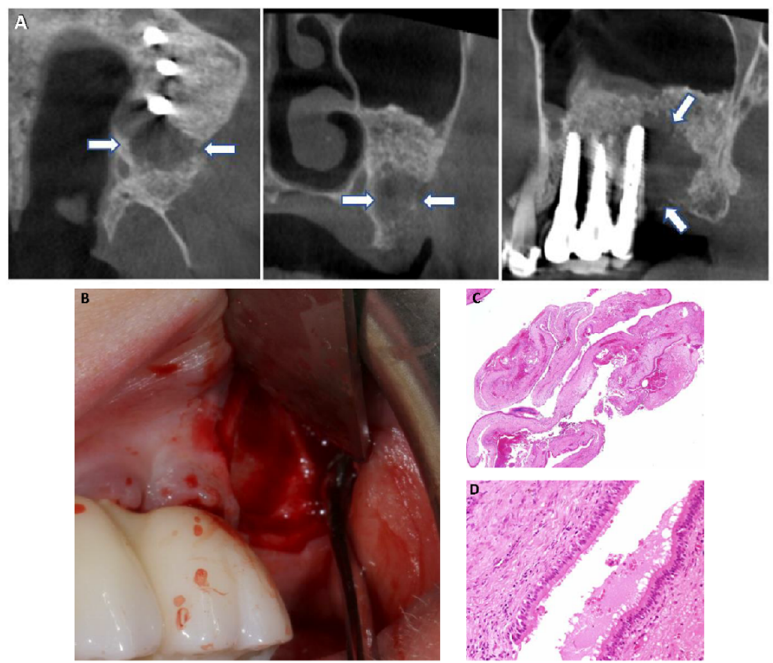
Figure 1. Cone-beam computerized tomography (CBCT) of the surgical ciliated cyst in present case #1, as seen in reconstructed slices in three planes: axial, coronal, and sagittal (left to right, A ); intra-operative view ( B ). The microscopic examination revealed a collapsed cystic structure ( C ); lined pseudostratified ciliated columnar epithelium typical of the maxillary sinus ( D ). ( C , D )—hematoxylin and eosin stain; (C)—X20 original magnification; (D)—X400 original magnification).